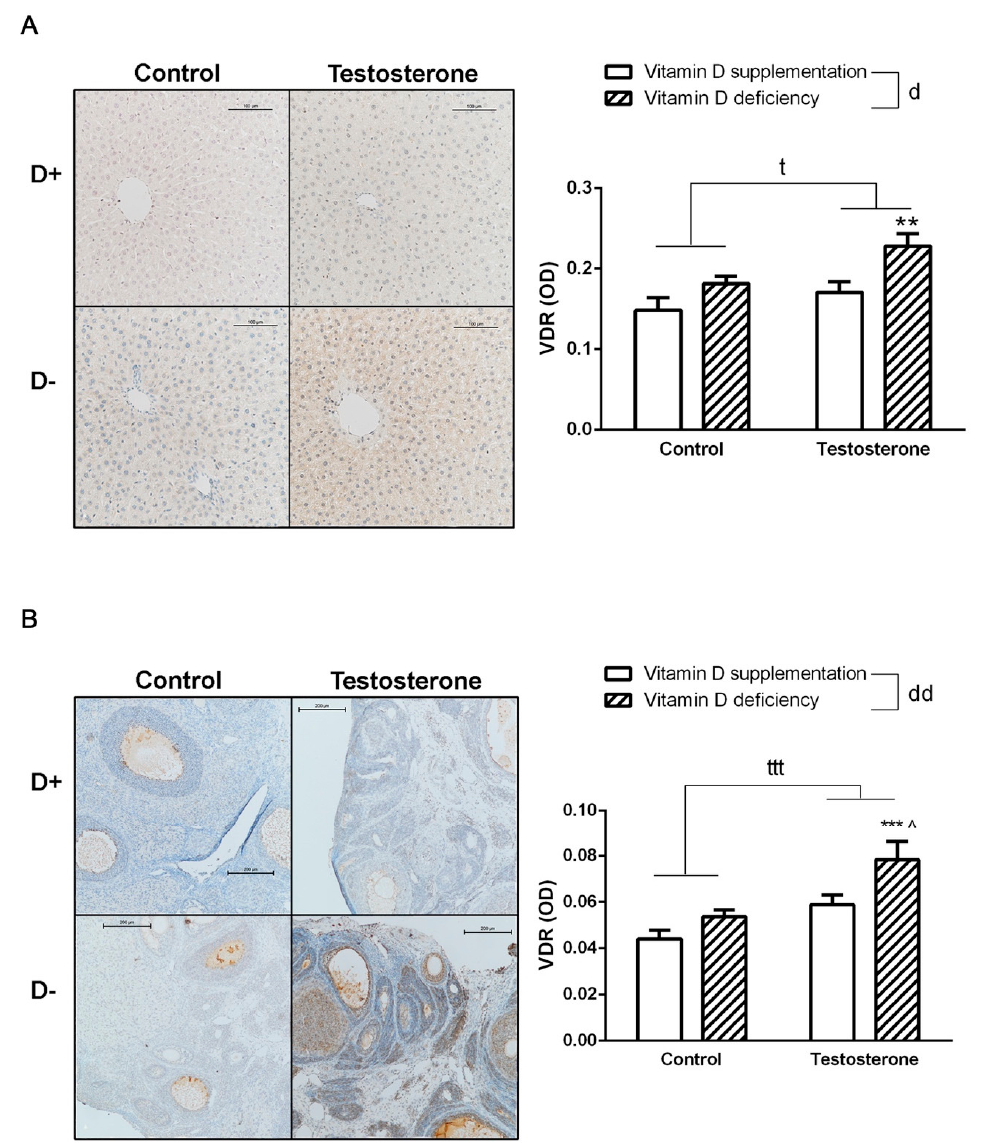
Figure 5. Vitamin D receptor density in the liver and in the ovaries. ( A ) Immunohistochemical staining of liver tissue with anti-VDR antibody. ( B ) Immunohistochemical staining of ovarian tissue with anti-VDR antibody. Data are presented as mean ± SEM. Two-way (factor 1—vitamin D supplementation vs. vitamin D deficiency, factor 2—control vs. testosterone treatment) ANOVA, t: p < 0.05 control vs. testosterone treatment, ttt: p < 0,001 control vs. testosterone treatment, d: p < 0.05 vitamin D supplementation vs. vitamin D deficiency, dd: p < 0.01 vitamin D deficiency vs. vitamin D deficiency; Tukey’s post hoc test (comparison of experimental groups), ** p < 0.01 vs. D + T– group,*** p < 0.001 vs. D + T– group, ˆ p < 0.05 vs. D–T– group; n = 5–8 in each group.